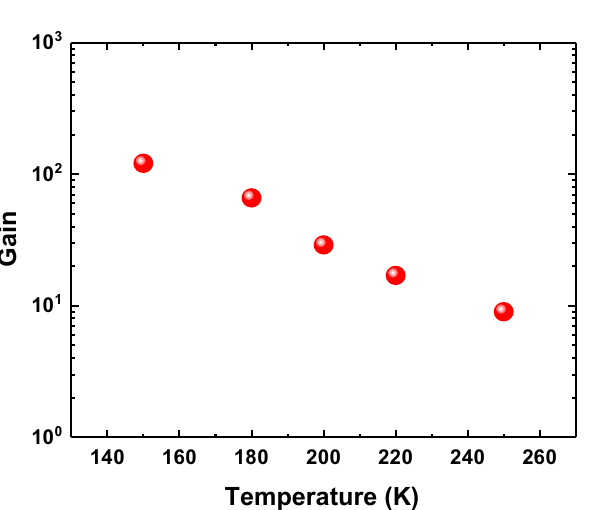
Figure 4. ( a ) Breakdown I-V characteristics and corresponding multiplication gain vs applied reverse bias at 200 K. Dark current and photocurrent are shown on the left axis; gain is shown on the right axis. ( b ) Simulated electric field profile under different applied reverse biases of SAM-APD structure.